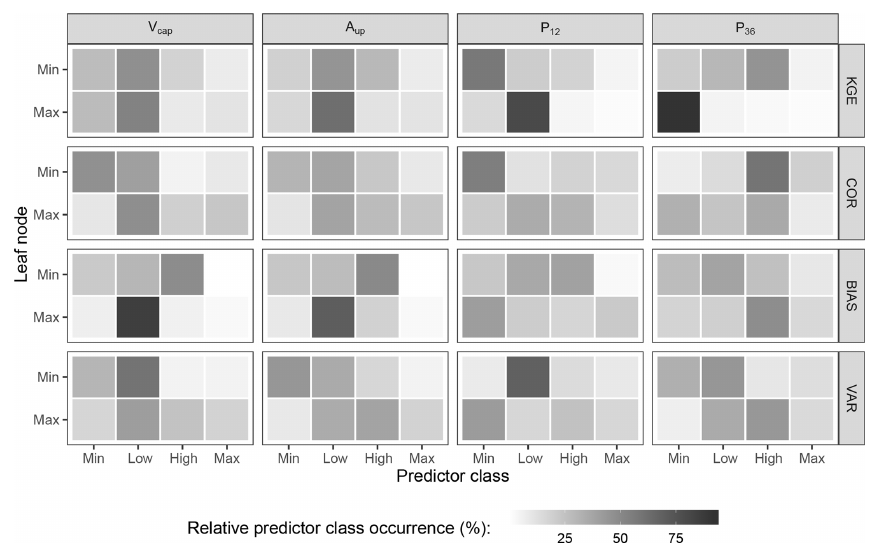
Figure 9. Relative distribution of predictor class occurrences within the largest and smallest valued leaf nodes aggregated over all regression trees of the random forest for each response variable. Shown are only the most important predictors.